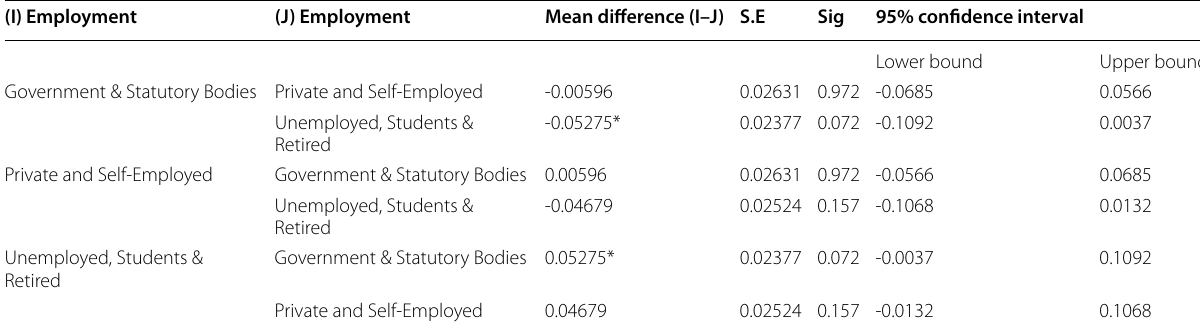
Table 6 Tukey’s HSD post hoc test about lifestyles of COVID-19 score according to respondents’